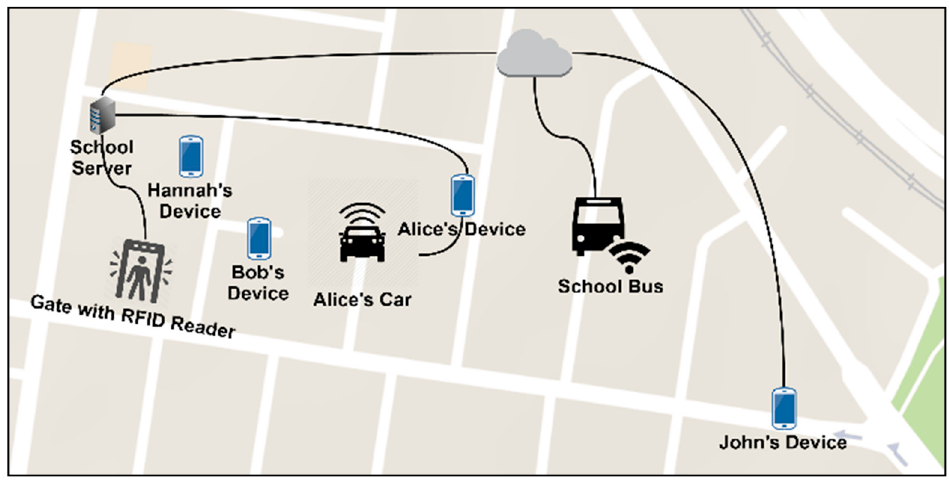
Figure 1. School safety use-case.